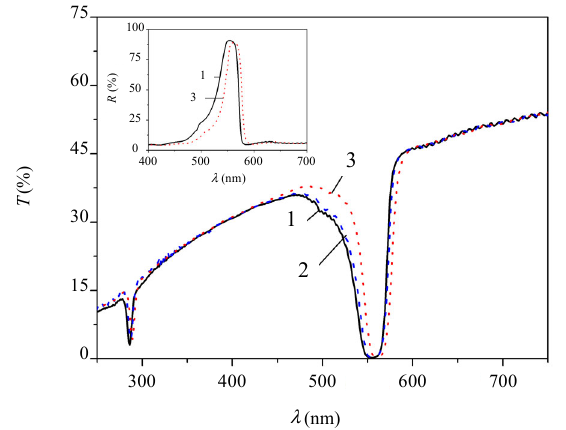
Fig. 6 Transmittance and reflectance (see the inset) spectra of initial AAO PC (1) and the same sample after 4 (2) cycles and 10 (3) cycles of impregnation and